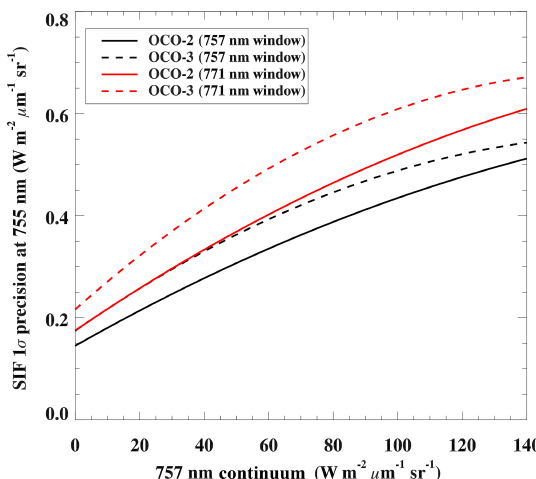
Figure 22. 1 σ precision of estimated SIF, using both the 757nm window (black) and the 771nm window (red), for OCO-2 (solid) and OCO-3 (dashed). SIF precision at 755nm was estimated from the 757nm (771nm) value by scaling by a factor of 1.10 (1.76), following Frankenberg et al. (2015). The OCO-2 values have been evaluated from the IDP posterior uncertainties in the actual SIF data product for an average of all eight footprints. The OCO-3 values have come from an early version of the preflight noise estimates, which are subject to